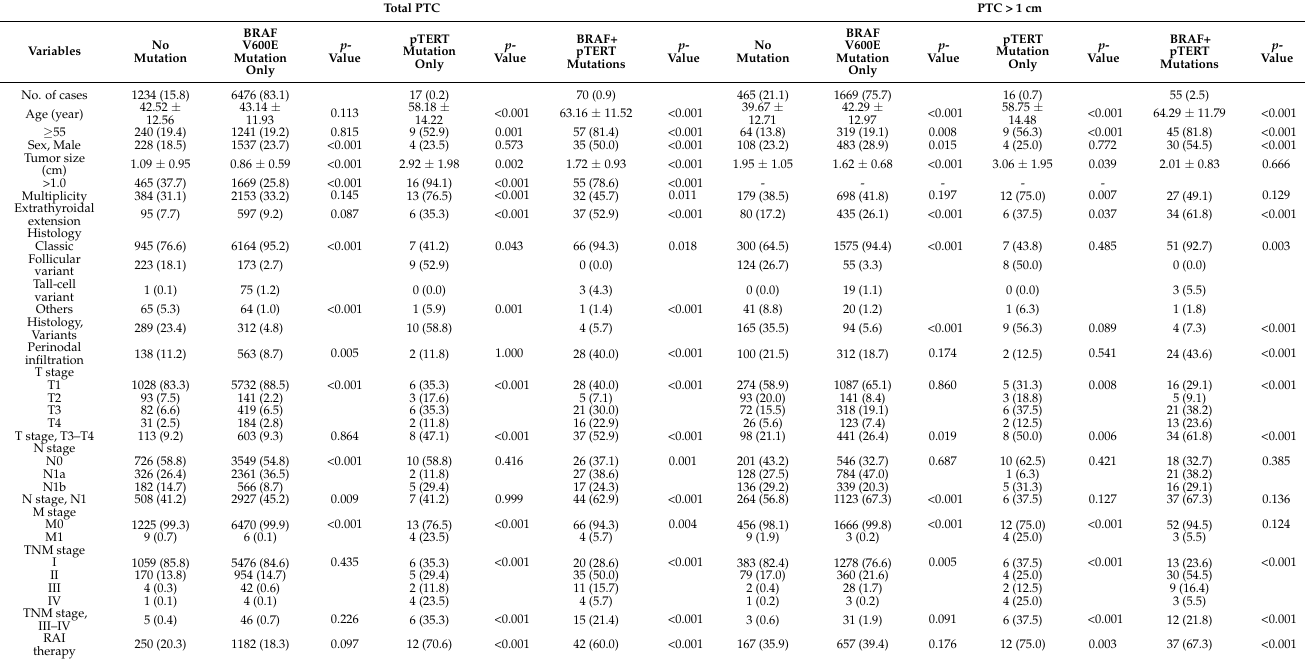
Table 3. BRAF and TERT promoter mutations and clinicopathologic features in patients with PTC. TotalPTC